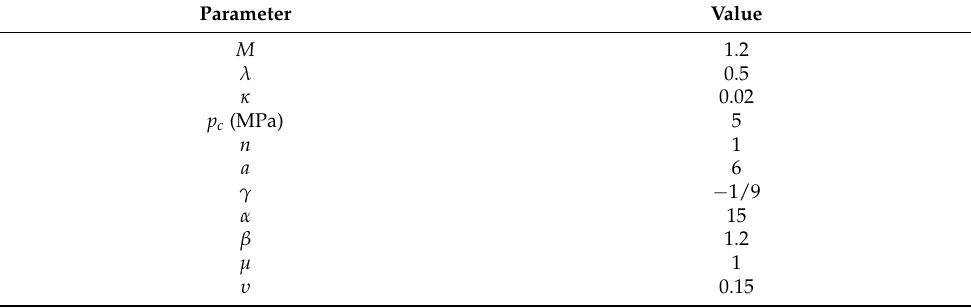
Table A4. Parameters adopted for simulation in Figure 10.